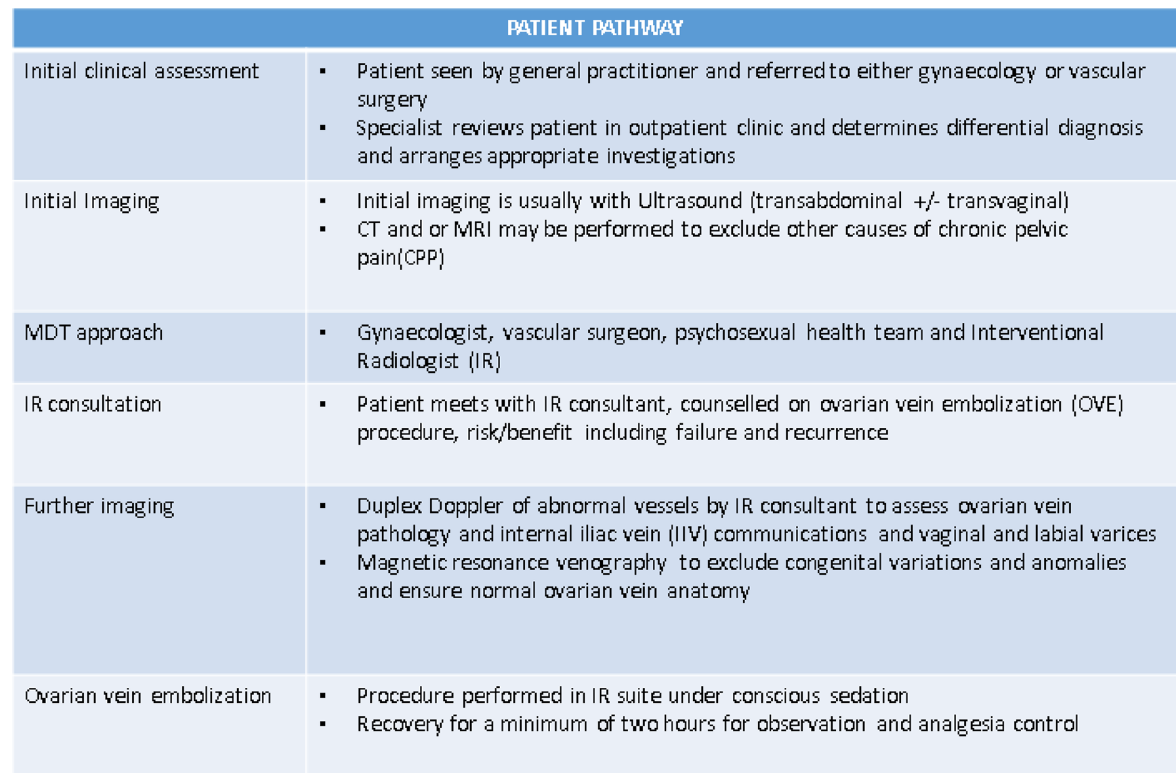
Table 1 Provides a suggested patient pathway for the management of patients with